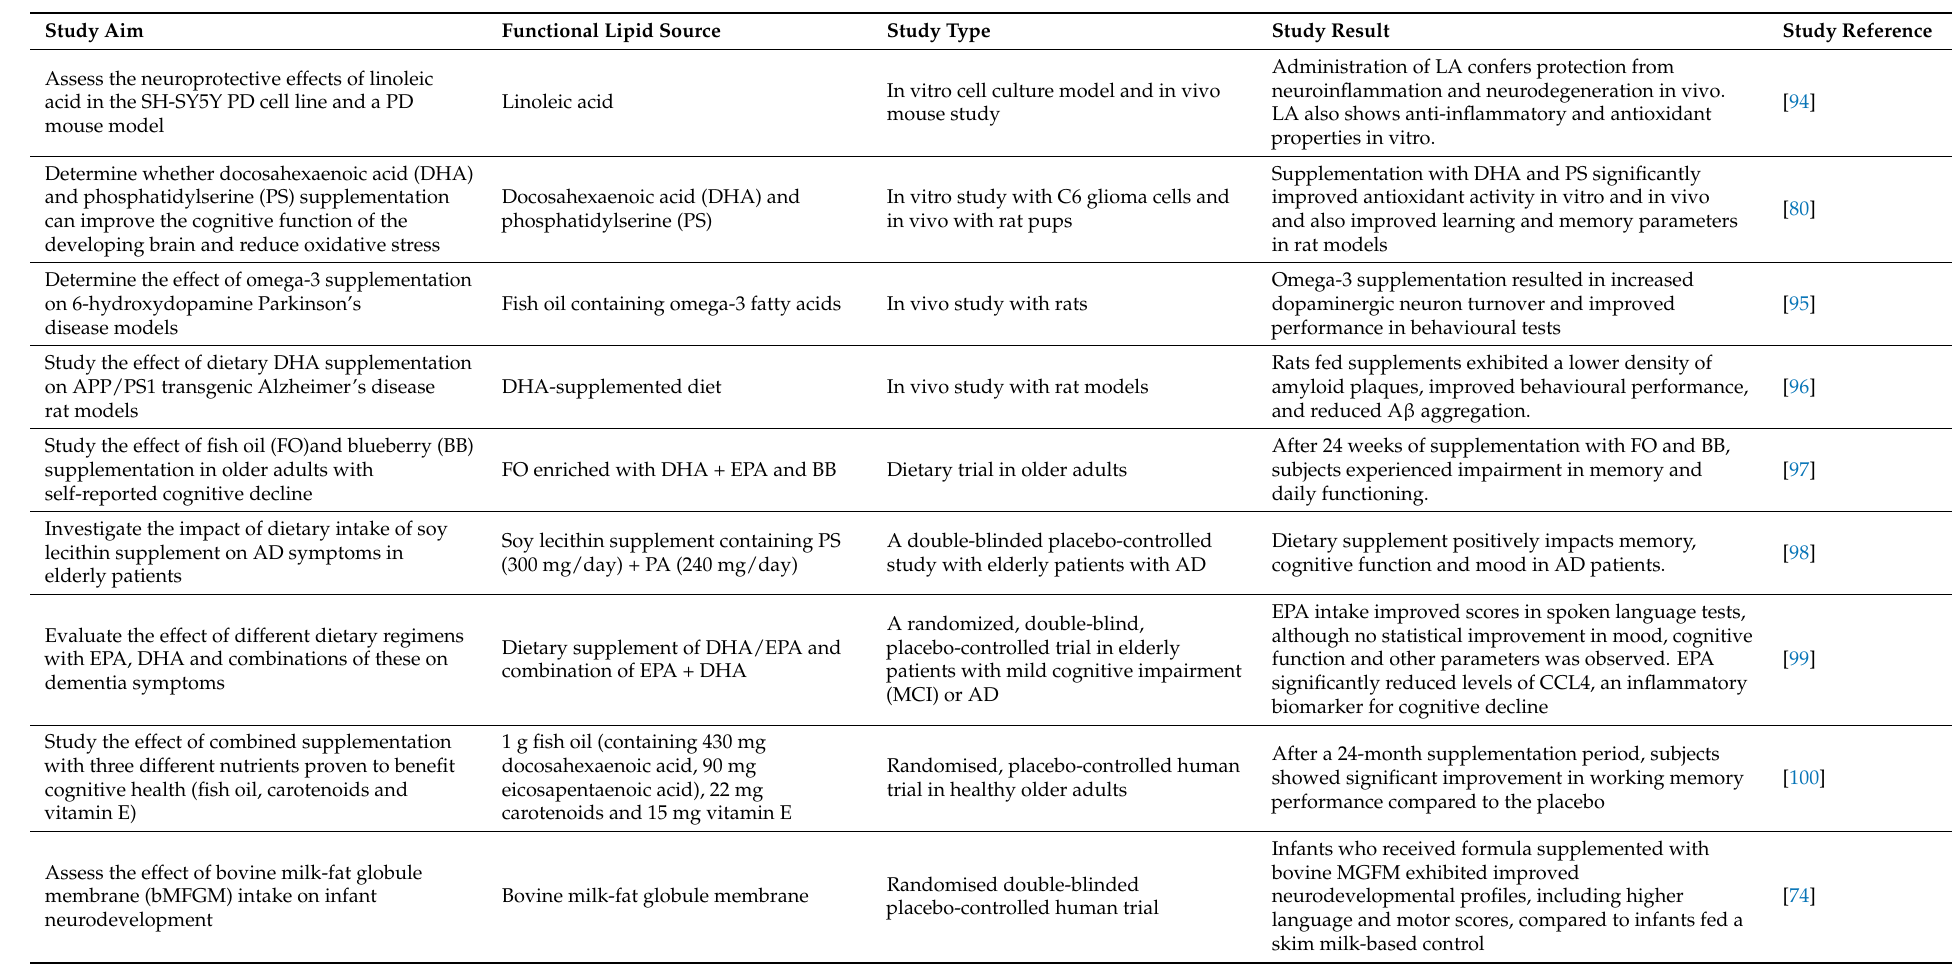
Table 2. Dietary supplementation with functional lipids improves cognitive function (human trials and animal